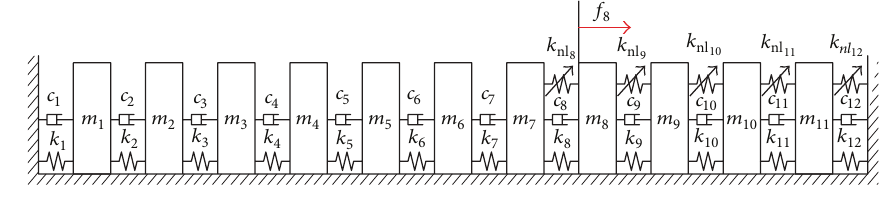
Figure 1: The discrete system model.